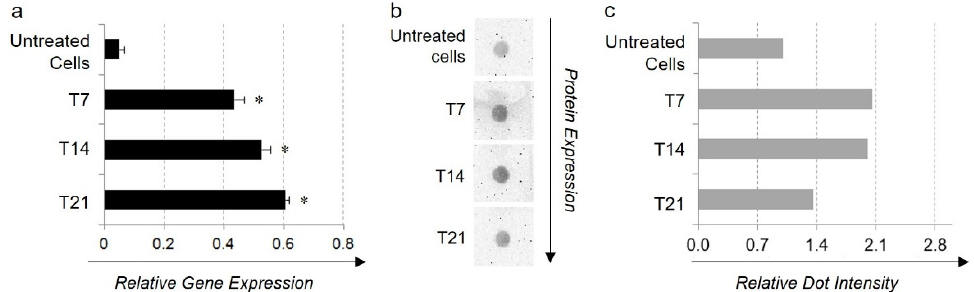
Figure 5. FVIII expression. ( a ) Real-Time PCR analysis of FVIII mRNA expression in untreated cells or in Ad-MSCs cultured in induction medium for 7 (T7), 14 (T14), and 21 (T21) days (*: p < 0.01 in comparison with the untreated cells). ( b ) Dot blot evaluation of FVIII release into the culture media of untreated cells and 7 (T7), 14 (T14), 21 (T21) day-differentiated Ad-MSCs. ( c ) Dot blot densitometry and relative intensity of protein dots calculated using Image J software. Results are normalized towards the undifferentiated sample.